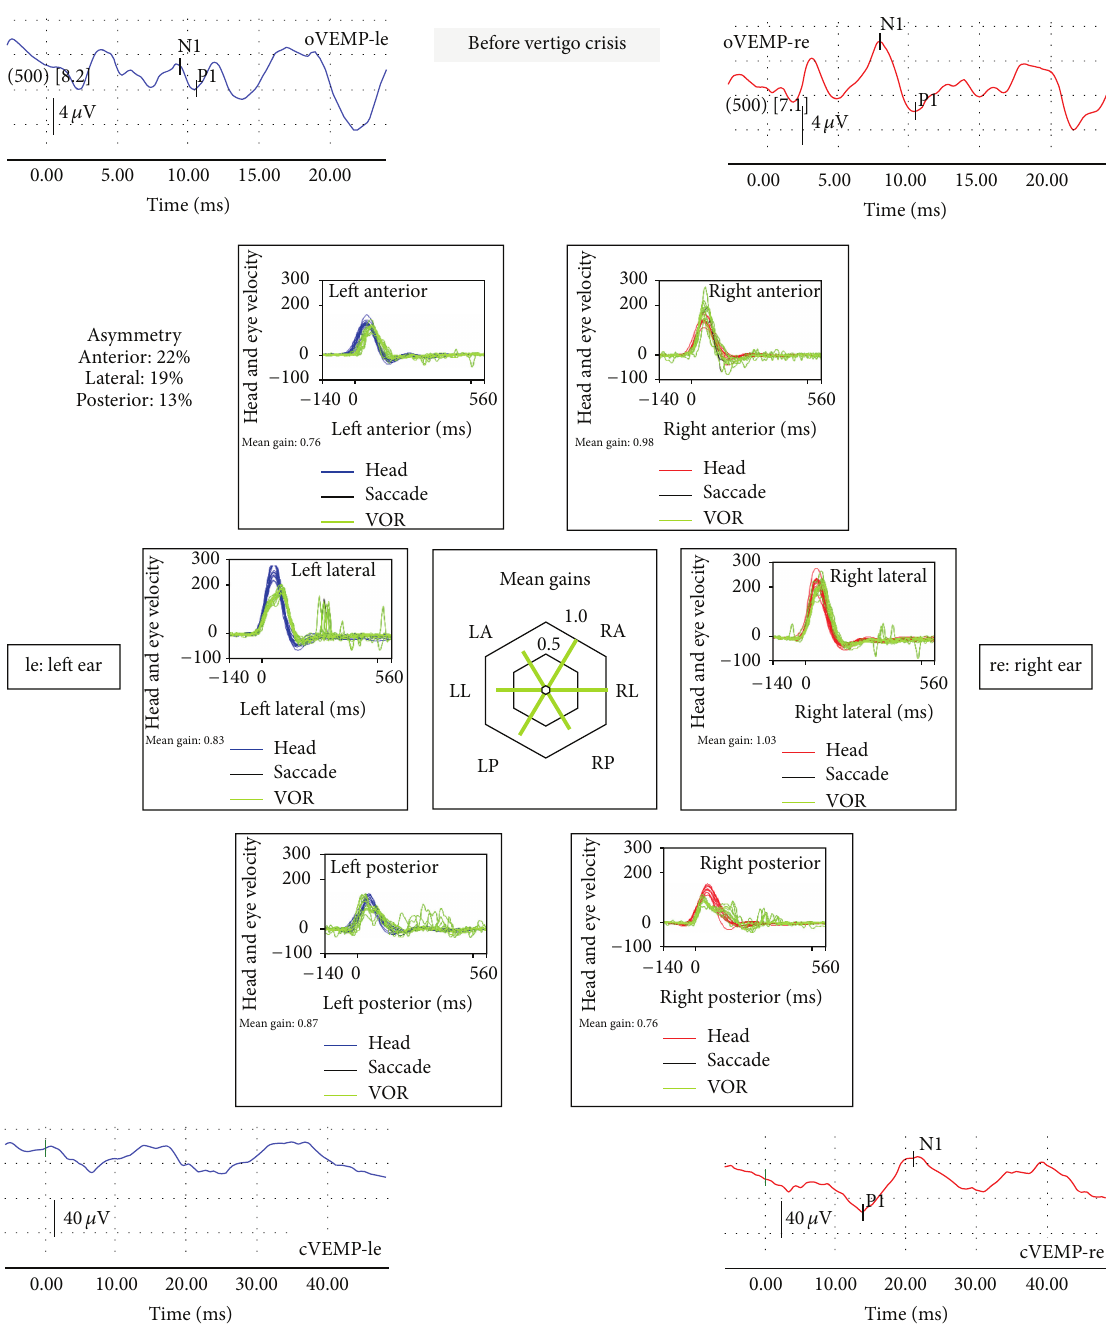
Figure 1: Vestibular examinations performed before the attack suffered by the patient. The vestibular myogenic evoked potentials for otolithic function, ocular (oVEMP) and cervical (cVEMP), are registered after bone vibration (500 Hz) with Bruel & Kjaer minishaker at the hairline (Fz); the response is abnormal on the left side/ear. The first component of the oVEMP (n10) is registered in the contralesional (right) eye that is very small or absent, whereas the n10 beneath the ipsilesional (left) eye is of normal amplitude. The sacculocollic cervical vestibular-evoked myogenic potential (cVEMP) is an uncrossed and predominantly sacculocollic response. The study of the vestibuloocular reflex with the video head-impulse test is normal except for the presence of reduced gain and overt saccades after left lateral semicircular canal